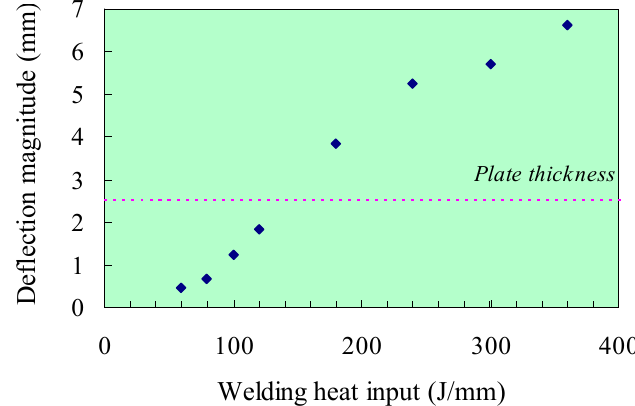
Figure 15. Relationship between welding heat input and maximum deflection.